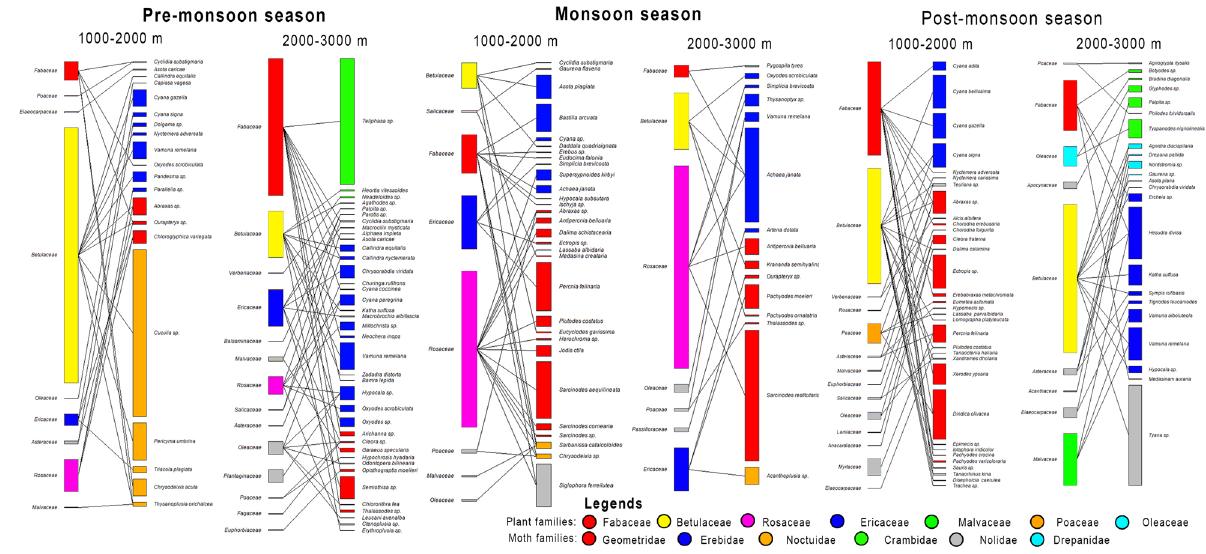
Figure 6. Seasonal and altitudinal wise settling moth-plant pollen transfer network (dominating plant families and moth families are coloured).